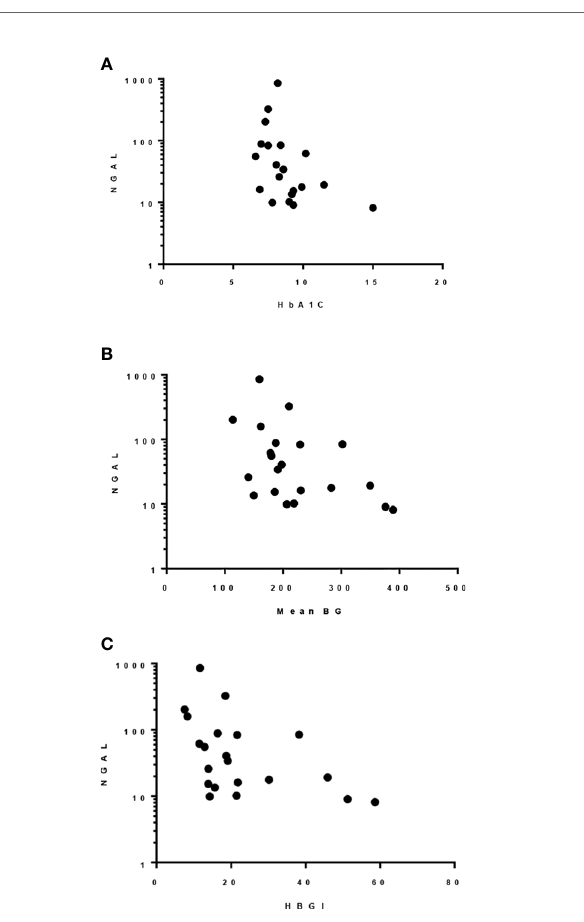
FIGURE 2 | Spearman correlation between uNGAL/Cr and: (A) HbA1c; r -0.509, p 0.022. (B) Mean BG; r -0.455, p 0.038. (C) HBGI; r -0.512, p